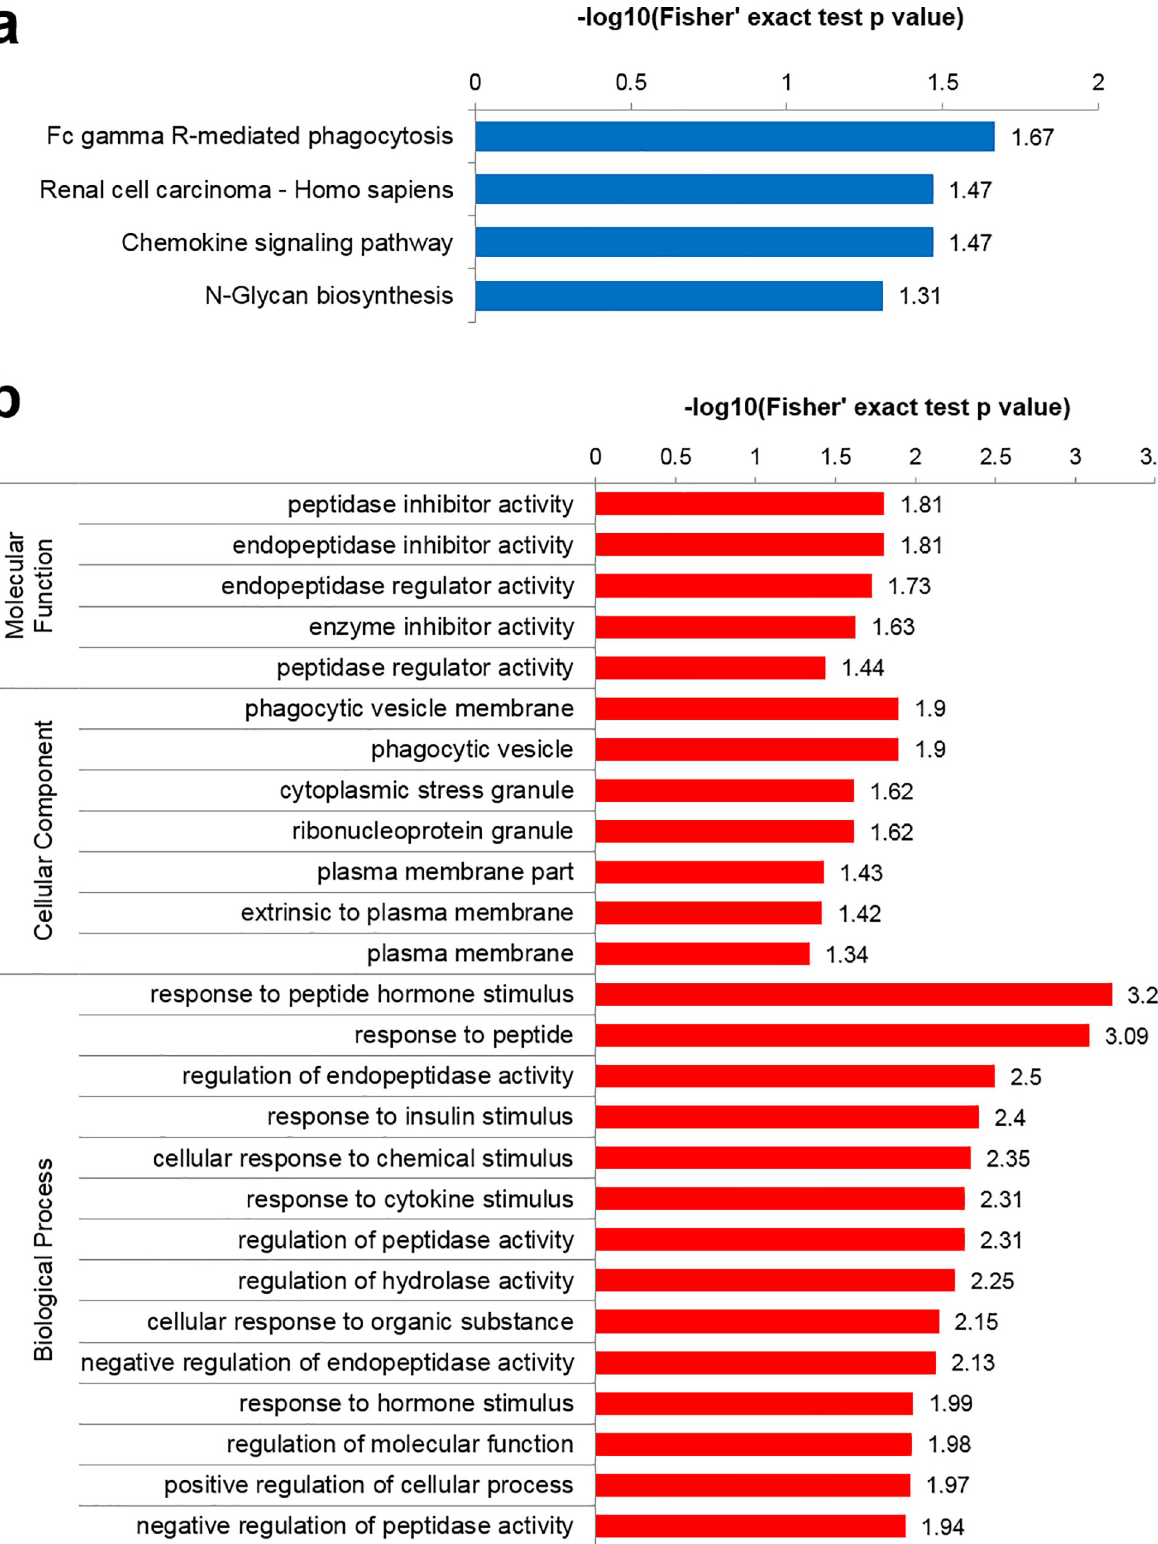
Fig 4. Functional analysis of proteins that were secreted at higher levels by PC3/nKR cells than by PC3 cells. (A) GO-based enrichment analysis and (B) KEGG pathway-based enrichment analysis of the proteins that were secreted at higher levels by PC3/nKR cells than by PC3 cells. https://doi.org/10.1371/journal.pone.0220807.g004 PLOS ONE | https://doi.org/10.1371/journal.pone.0220807 August 12,